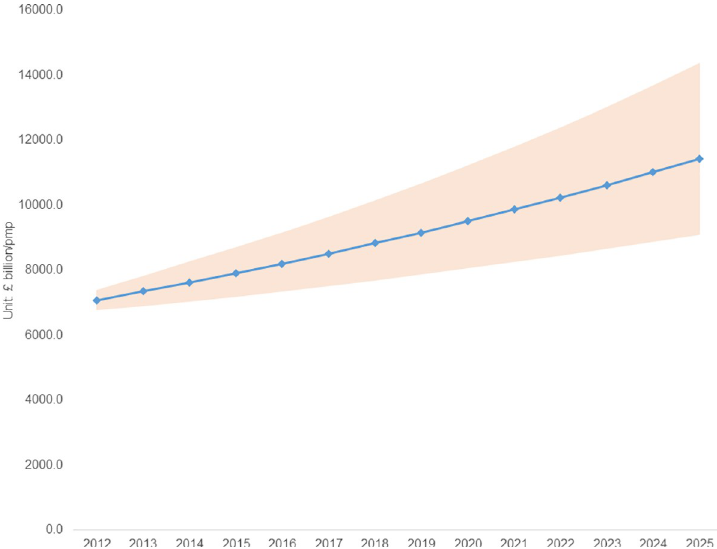
Fig 3. Projected economic burden of stages 3–5 CKD from 2012 up to 2025 in the UK. pmp: per million diabetic population. Line represents the prediction economic burden per million diabetic population from 2012 up to 2025; the dark area represents 95% Confidence Intervals